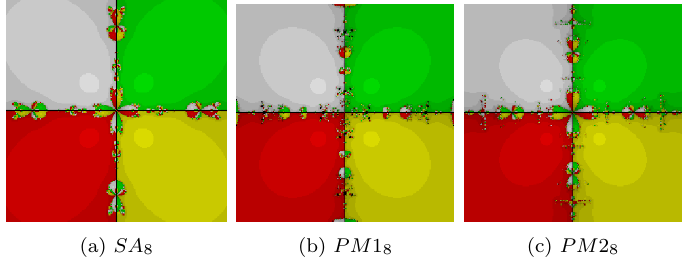
Figure 2. The methods for test problem